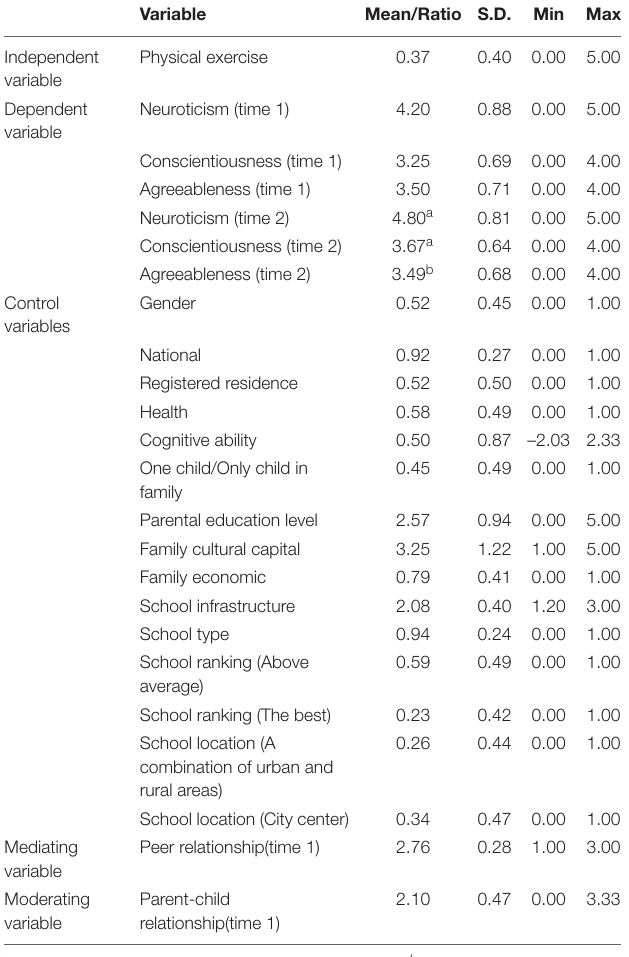
TABLE 1 | Sample descriptive statistics information ( N =